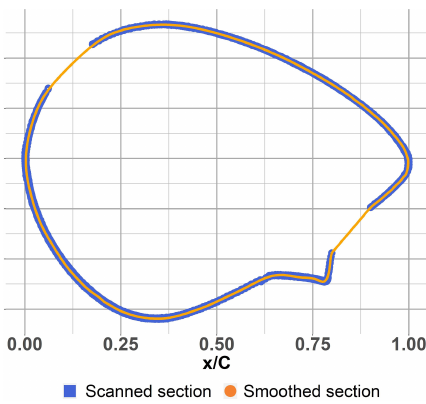
Figure 1. Scanned section and smoothed section at radial position = 13%). The blue square (blue (cid:4) ) shows the scanned point R6 ( r R cloud, while the orange dot (orange • ) shows the smoothed section.